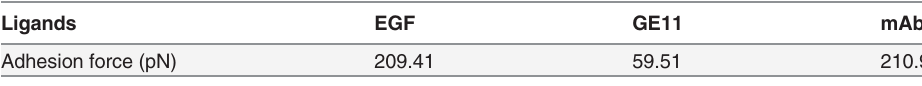
Table 2. Adhesion force of ligands to EGFR based on Fig.